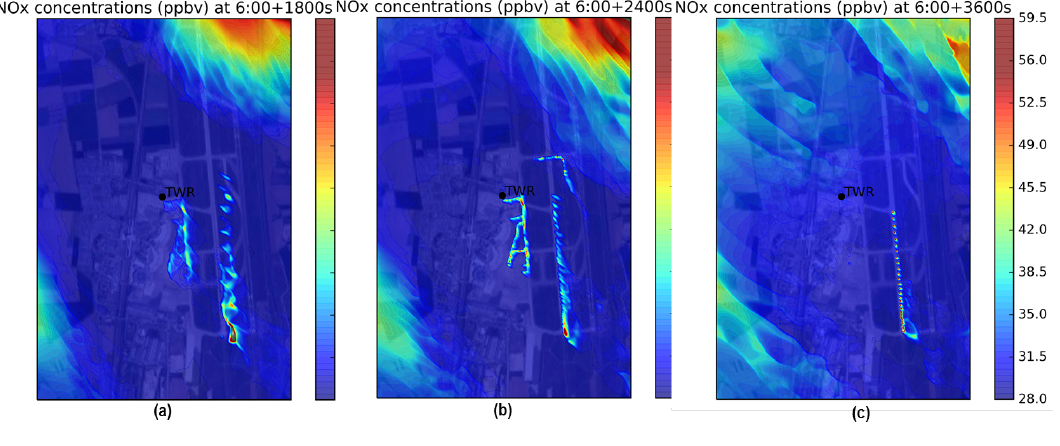
Figure 6. NO x concentration (ppbv) at 2 m above ground: ( a ) at 6:30 UTC; ( b ) at 6:40 UTC; ( c ) at 7:00